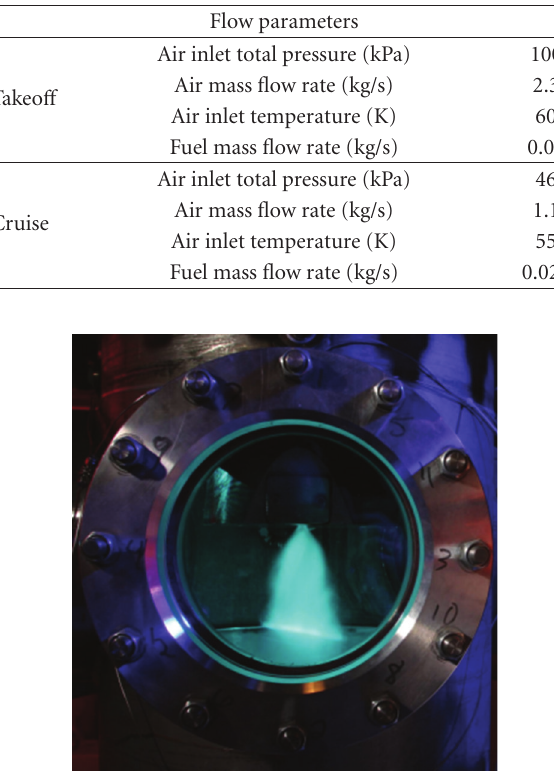
Figure 2: Fuel spray measurements in the GTL